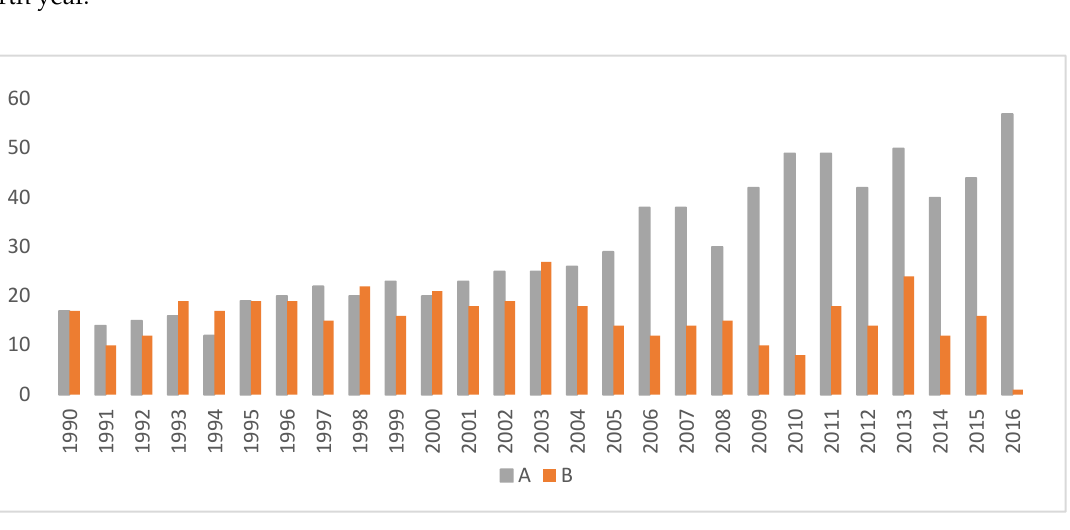
Table 4. E ff ect of the inbreeding coe ffi cients for the examined traits. Variables